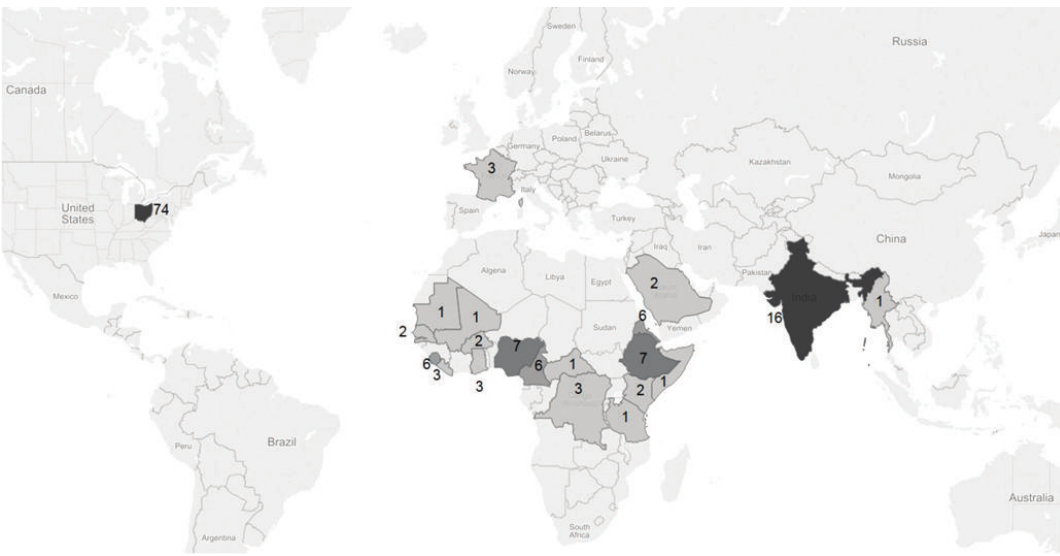
Figure 1: Country visited by world travelers before being confirmed with malaria in Ohio from 2010 through 2014.